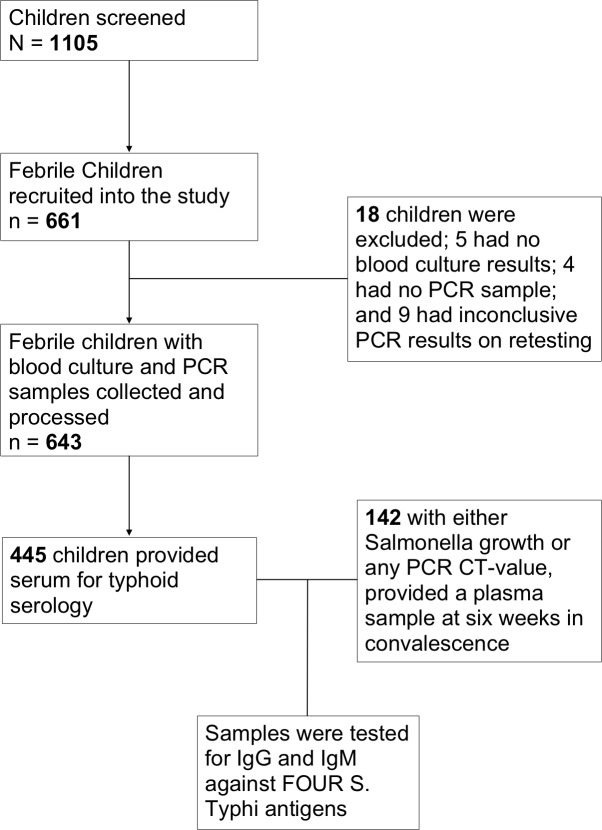
Flowchart of participant recruitment.Numbers of children screened, recruited and processed on PCR, blood culture and serology are provided.